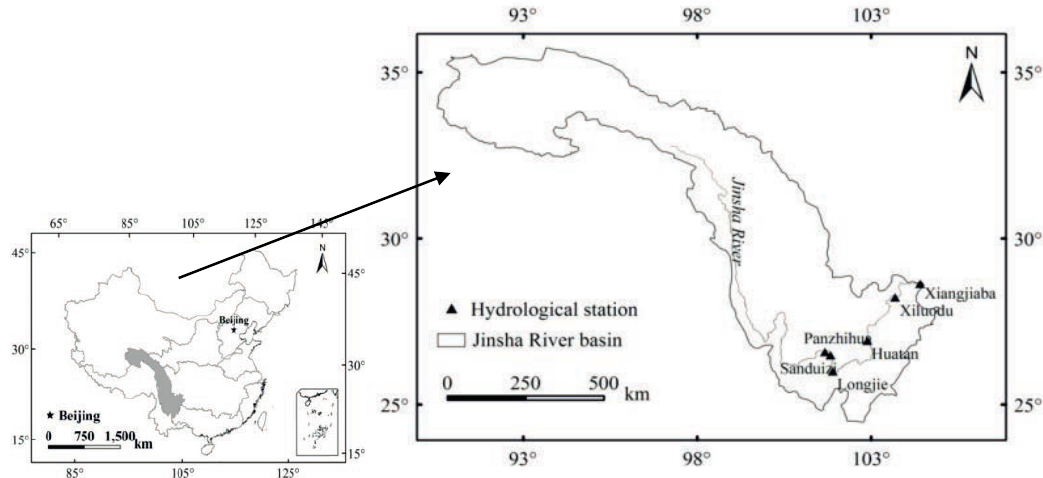
Fig. 1 Location of the Jinshajiang River basin and some hydrological